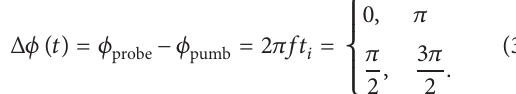
phase differences, called in-phase and quadrature phase, are